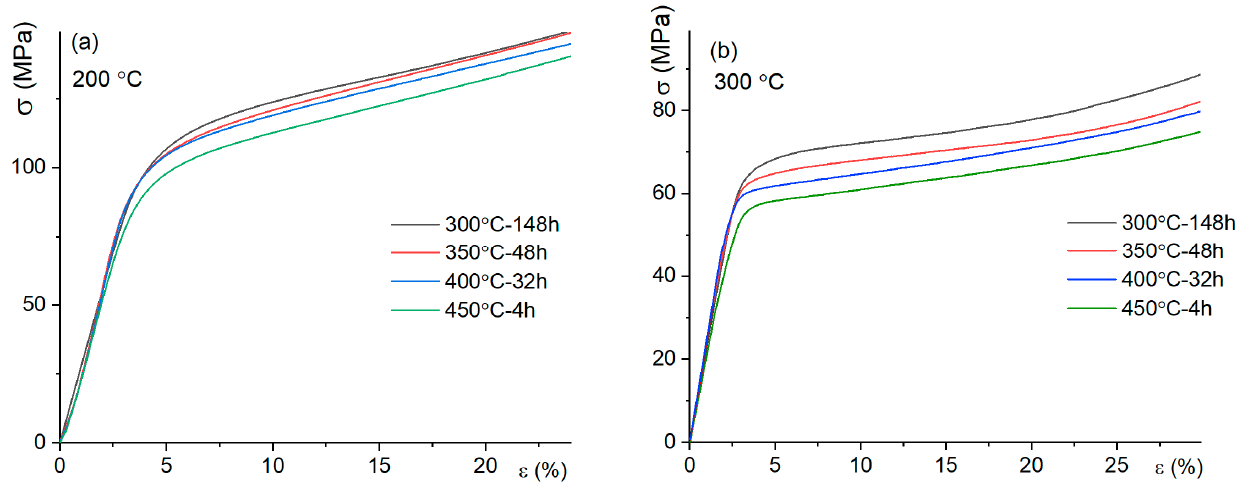
Figure 8. ( a , b ) Engineering stress–engineering strain compression curves at temperatures of ( a ) 200 °C and ( b ) 300 °C for the Al-2%Cu-2%Mn alloy heat-treated with different ageing regimes and final stabilizing aging at 300 °C to 1 h.